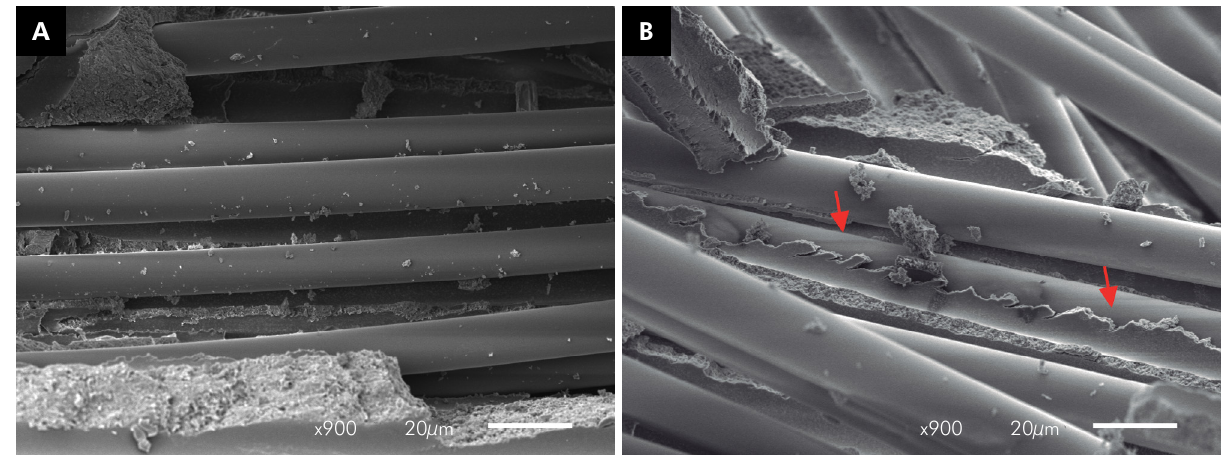
Figure 8. SEM analysis revealing the interaction between the fibers and resin matrix in groups that were or were not preheated.